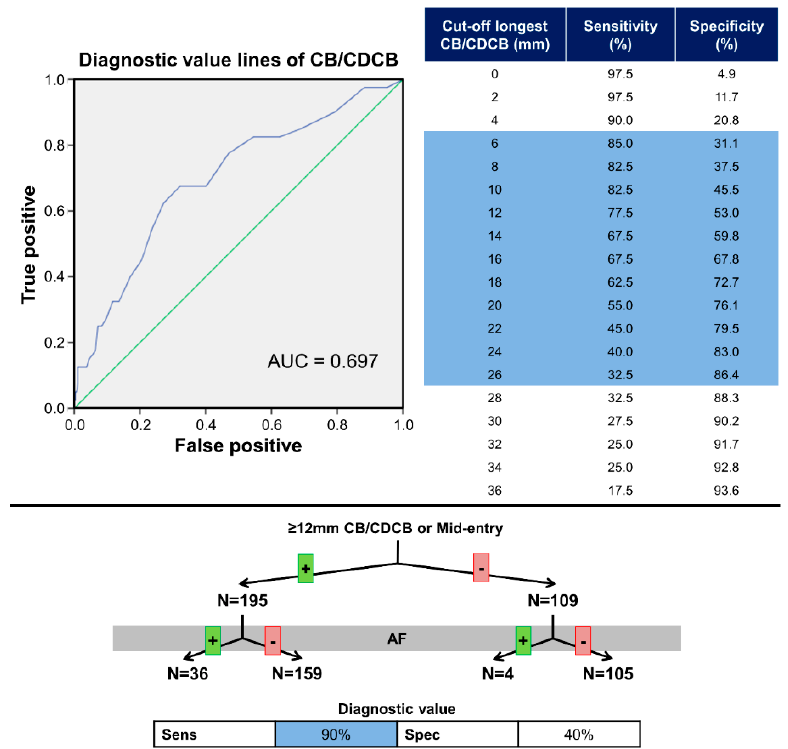
Figure 5. Predictive value of entry-site and conduction disorders. ( Upper panels ) Predictive value of the length of conduction disorders for previous AF episodes. The left panel depicts a ROC curve for length of lines of conduction disorders, The right panel cut-off values of the length of conduction disorders and previous AF episodes. ( Lower panel ) Flowchart demonstrating the predictive value of mid-entry site and a line of conduction block or CDCB of 12mm or more. Table shows sensitivity and specificity. AF = atrial fibrillation; CB = conduction block; CDCB = connected conduction delay and block; Sens = sensitivity; Spec = specificity.